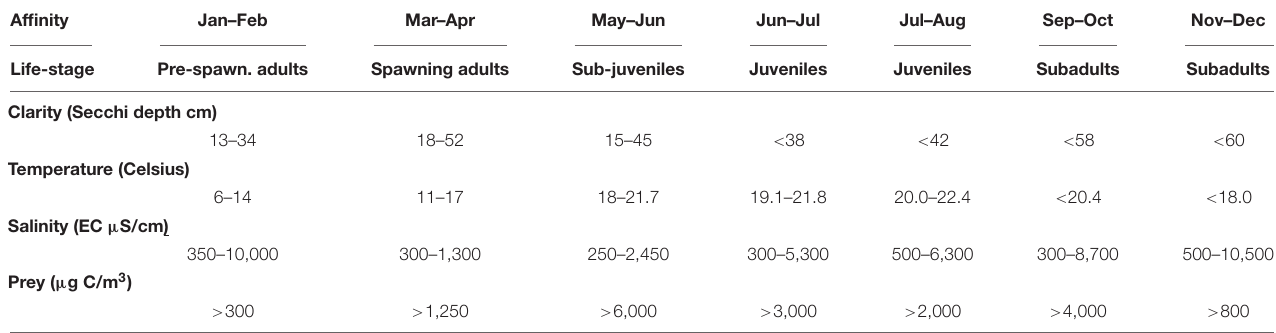
TABLE 1 | Ranges of adequate conditions for four environmental factors that impact the distribution of delta smelt, drawn from occupancy studies in Hamilton and Murphy (2020).